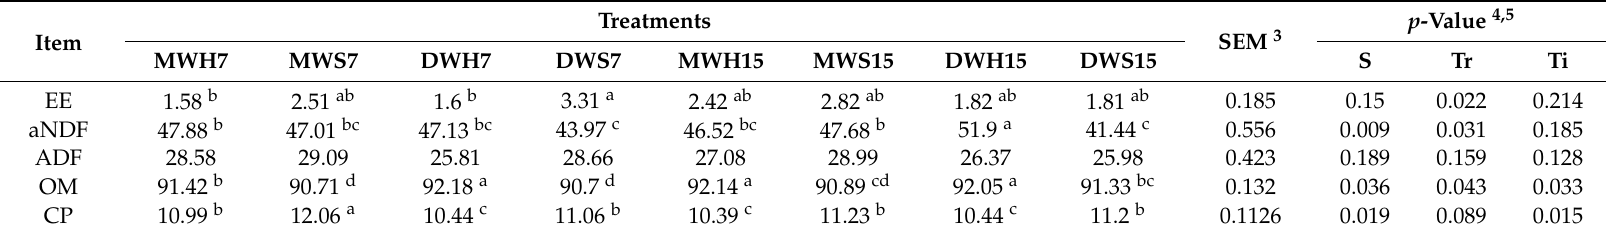
Table 1. The chemical composition 1 of di ff erent treatments 2 (%, dry matter—DM